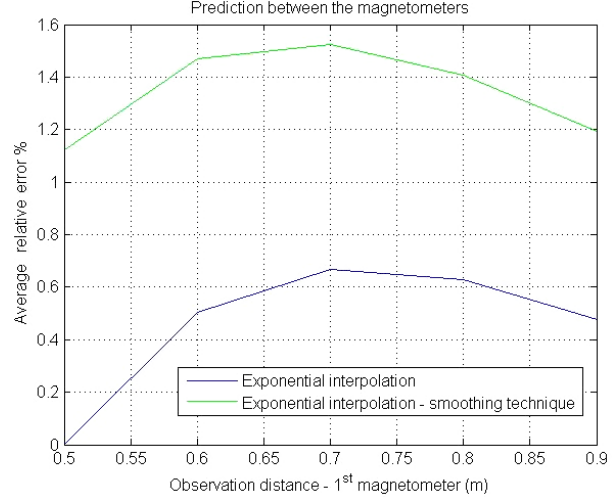
Figure 5. Magnetic field’s average relative error with respect to the first magnetometer’s position with fixed spacing 30, 40, 50, and 60cm between the magnetometers, using the smoothing technique. The dipole’s field r − 3 power law is also shown for comparison.